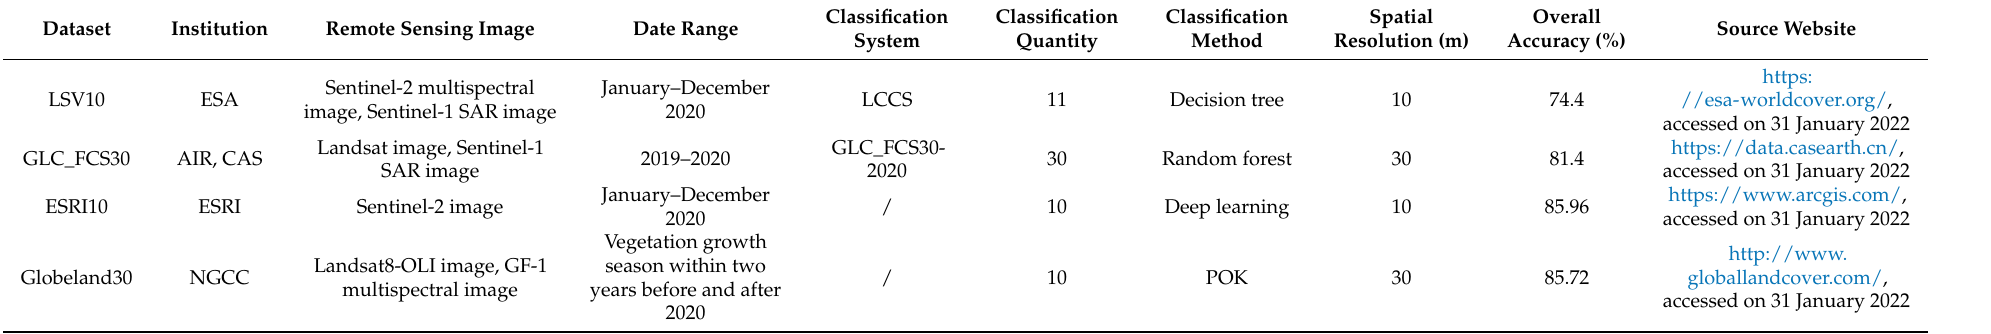
Table 1. Brief summary of the 4 LULC